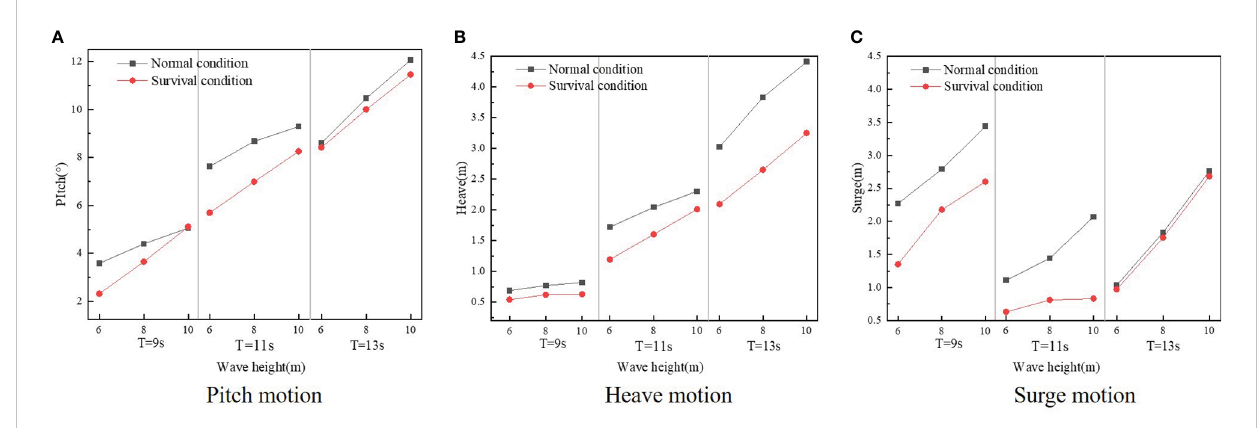
FIGURE 14 Motion response comparison of fi sh farm platform under different operating conditions.